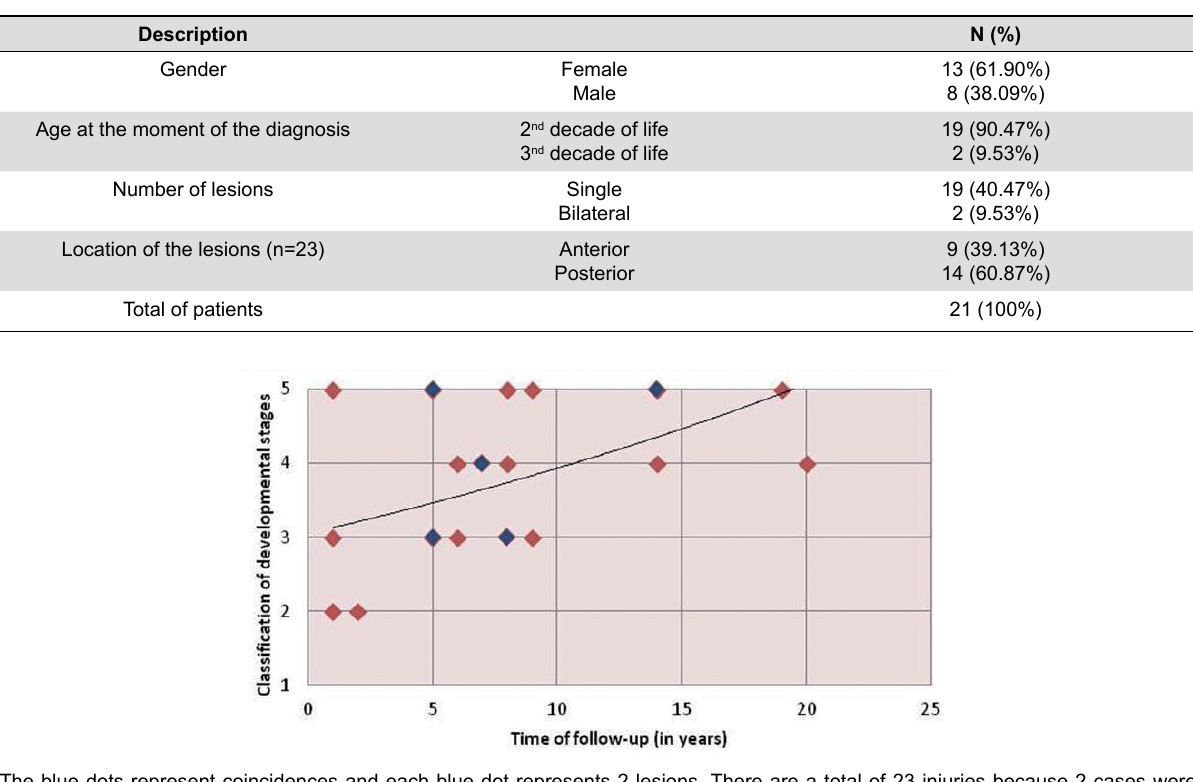
*The blue dots represent coincidences and each blue dot represents 2 lesions. There are a total of 23 injuries because 2 cases were bilateral Figure 1- Distribution of idiopathic bone cavity (IBC) lesions in accordance with classification of developmental stage and follow-up